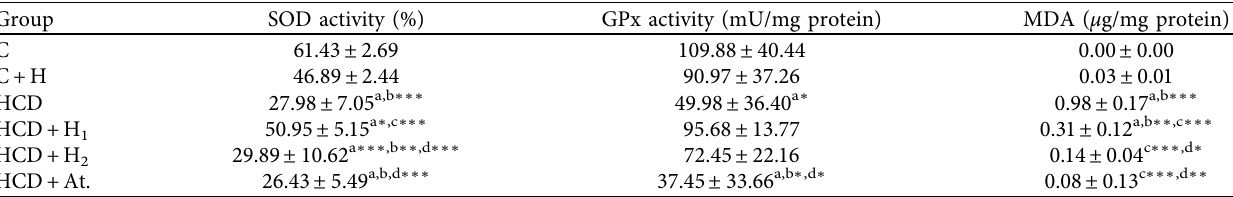
Table 4: Effect of Trihoney on activities of SOD and GPx and on MDA concentration in liver homogenate of NAFLD at week 12.